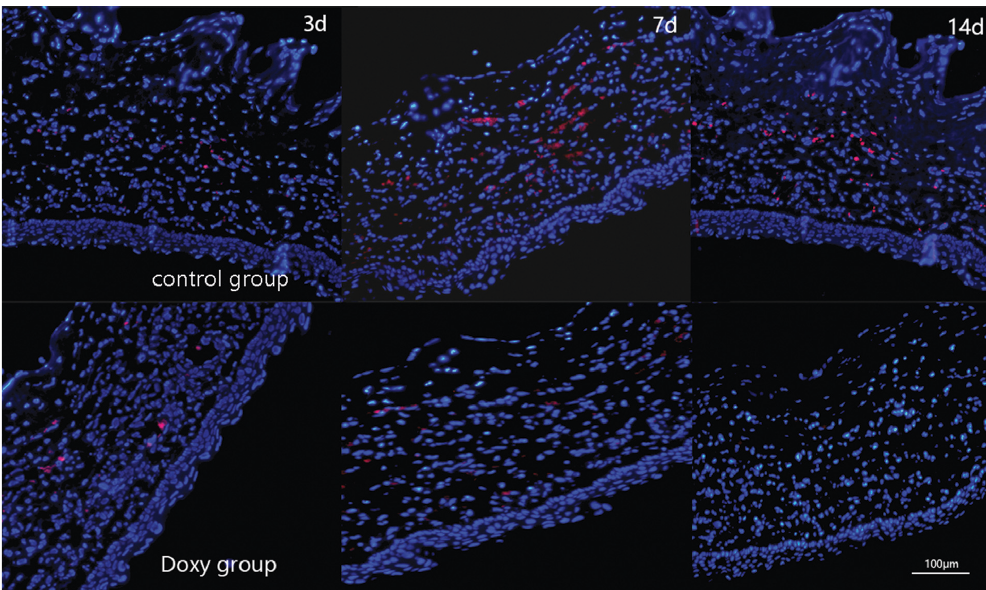
Figure 5: Immunofluorescence staining in the doxycycline group and the control group 3, 7, and 14 days after corneal alkali burn. DAPI was used for nuclear staining (blue). Immunofluorescent staining for α -SMA was weaker than in the control group 3, 7, and 14 days after